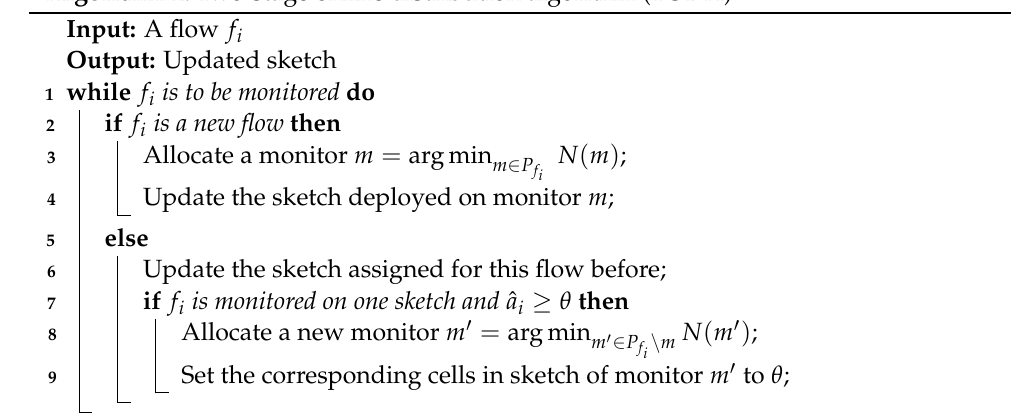
Algorithm 2: Two-stage online distribution algorithm